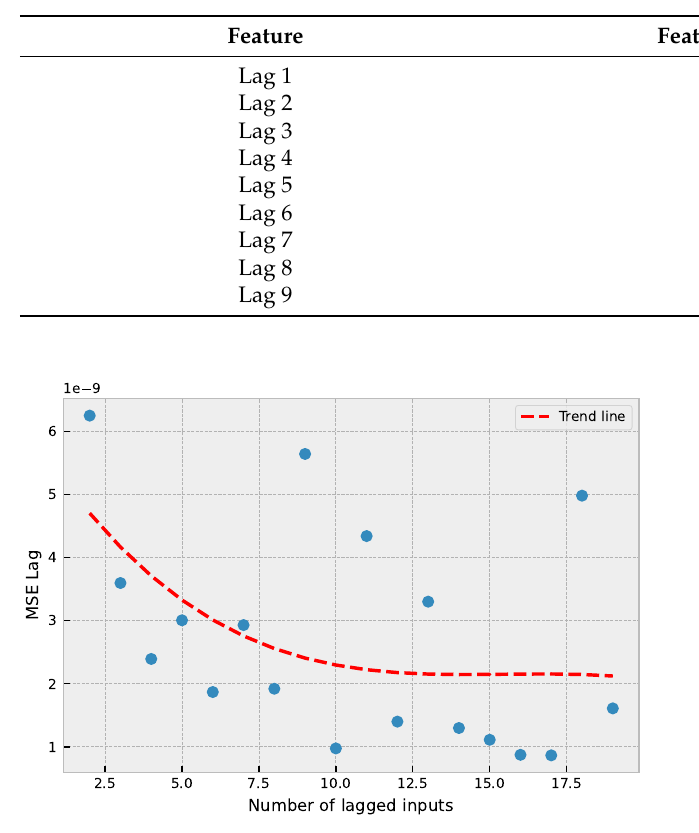
Figure 9. MSE Lag × number of lagged